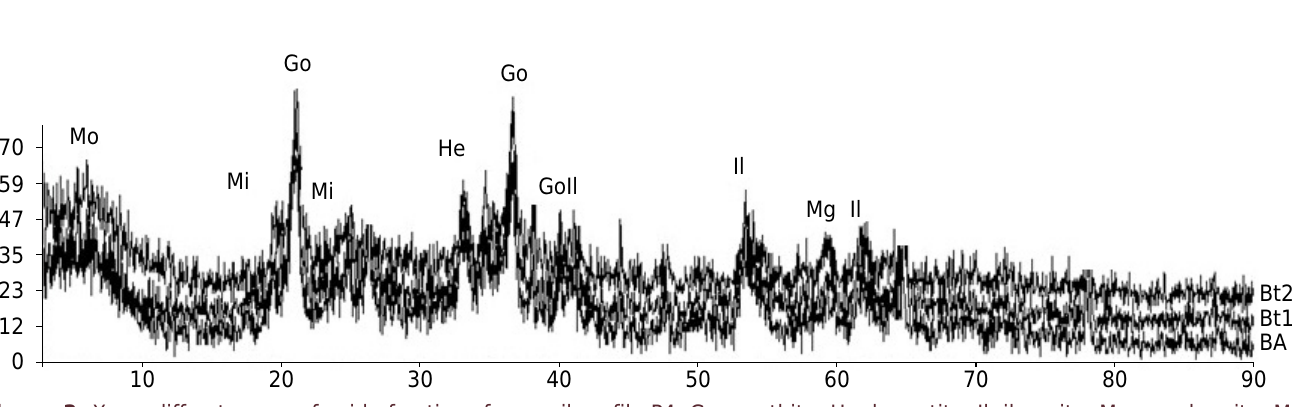
Figure 3. X ray diffractogram of oxide fractions from soil profile P4. Go: goethite, He: hematite, Il: ilmenite, Mg: maghemite, Mo: montmorillonite, Mi: